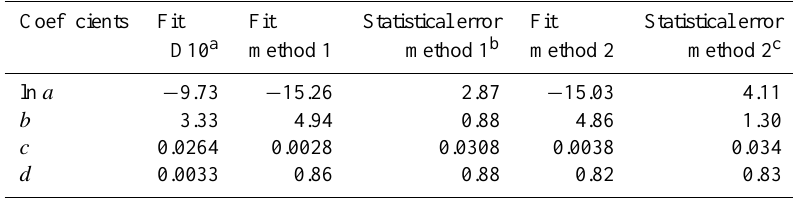
Table 2. Equation (1) fit coefficients.